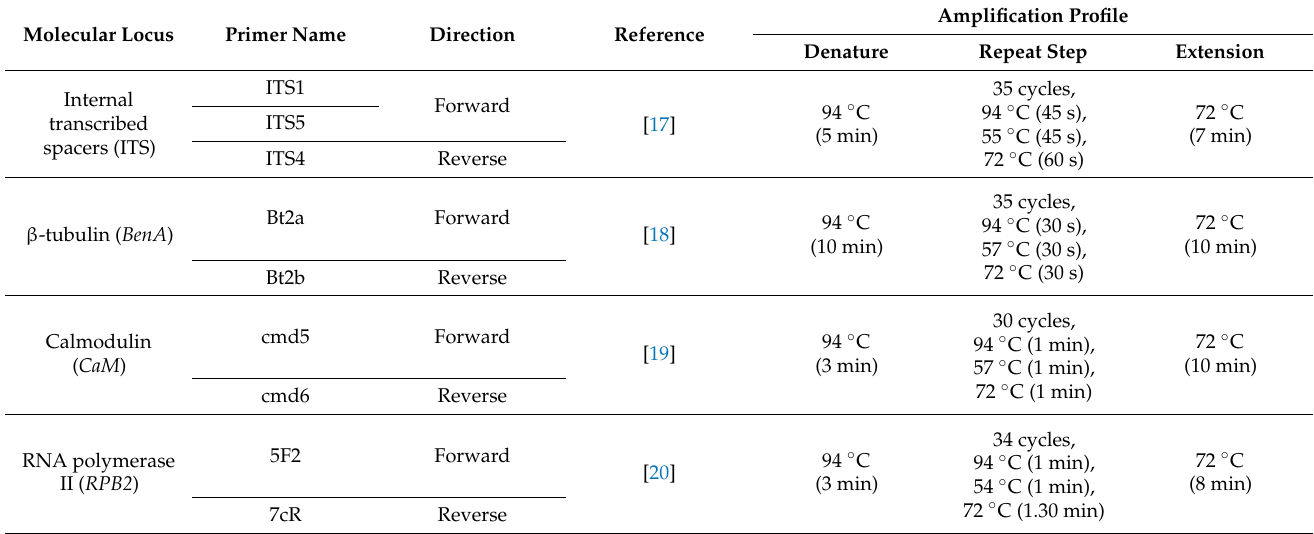
Table 1. Molecular markers, primers, and amplification profiles used and generated in this study.